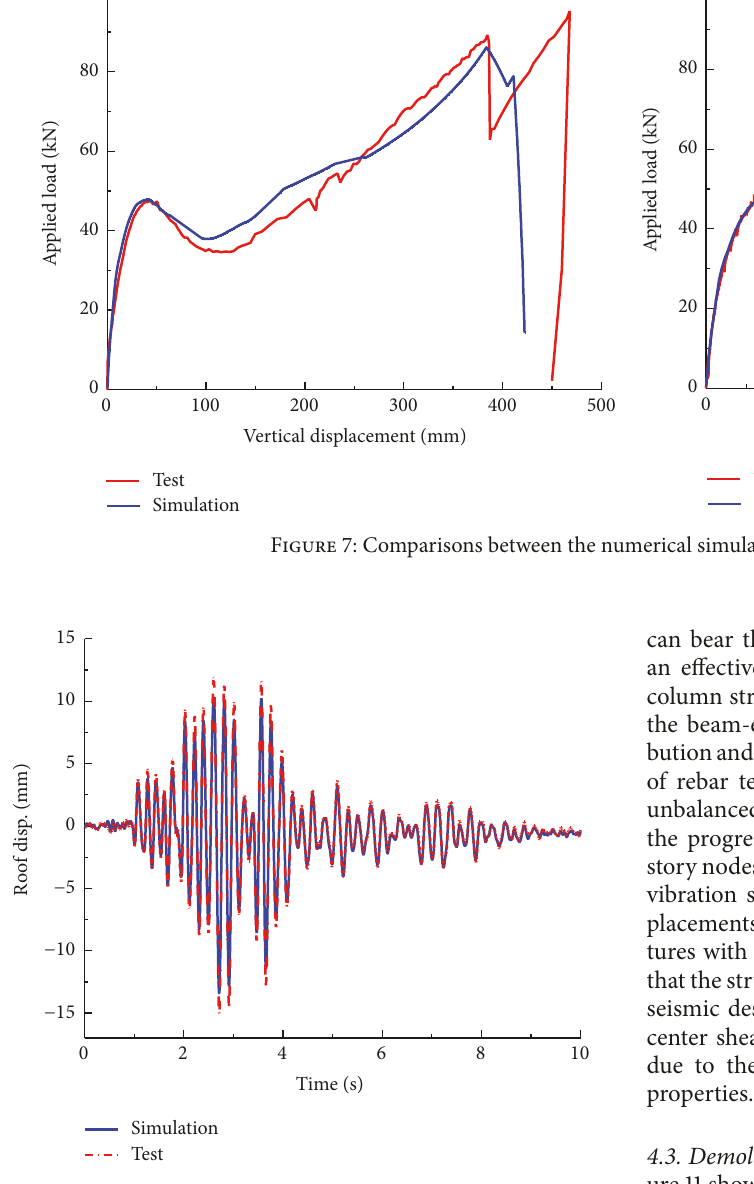
Figure 8: Comparisons between the numerical simulations and the test